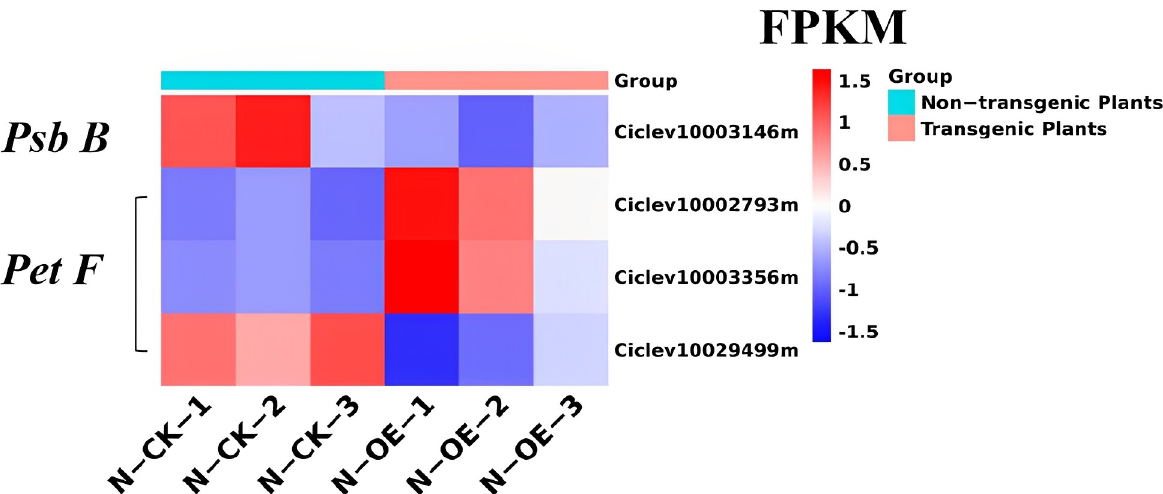
Figure 7. The FPKM of the DEGs in the photosynthesis pathway in the non-transgenic plants versus the transgenic plants. The N − CK − 1 − 3 means the non-transgenic plants, the N − OE − 1 − 3 means the transgenic plants. Other figures were the